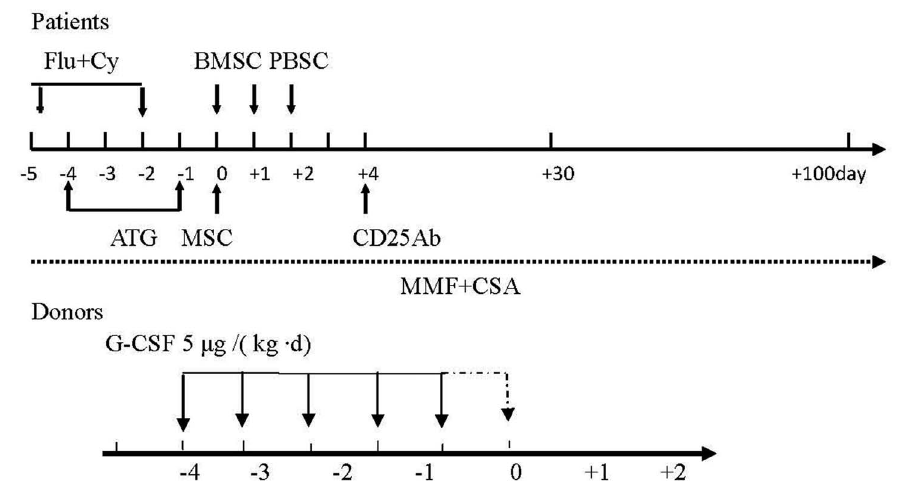
Figure 1. Graphic representation of conditioning regimen.